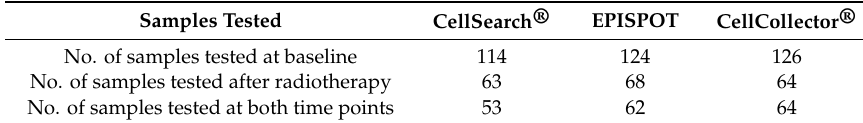
Table 2. Number of blood samples tested with each circulating tumor cells (CTC) enumeration method.